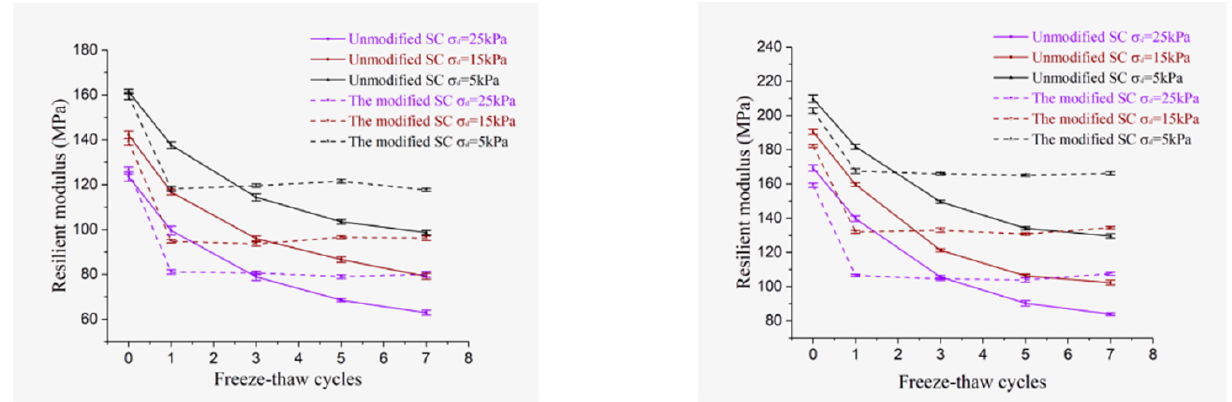
Figure 2. Variation curves of resilient modulus for test soils after F–T cycles of loading process [25].